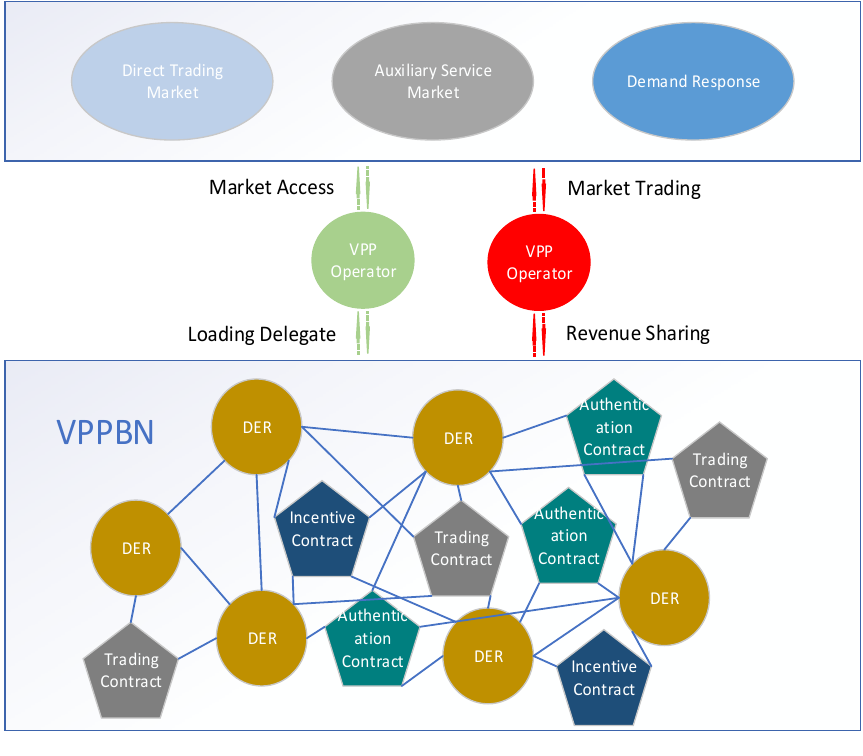
Figure 1. Virtual power plant trading model.